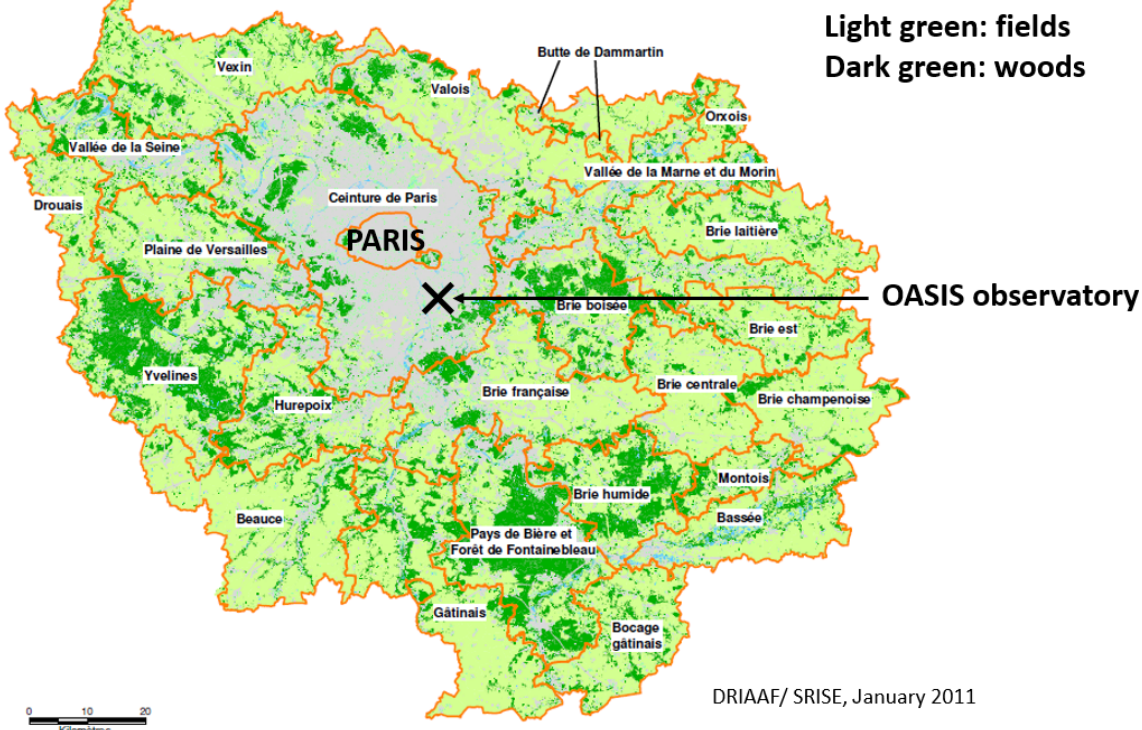
Figure 1. Location of the FTIR–OASIS observatory providing NH 3 total columns in the Paris region (France). One can see that the Paris megacity is very urbanized close to the city center and is surrounded by a large rural belt with 49% agriculture surfaces (Direction Ré- gionale de l’Agriculture et de la Forêt, DRIAAF, http://driaaf.ile-de-france.agriculture.gouv.fr/IMG/pdf/RA_R11_cle4ce9b1.pdf, last access: